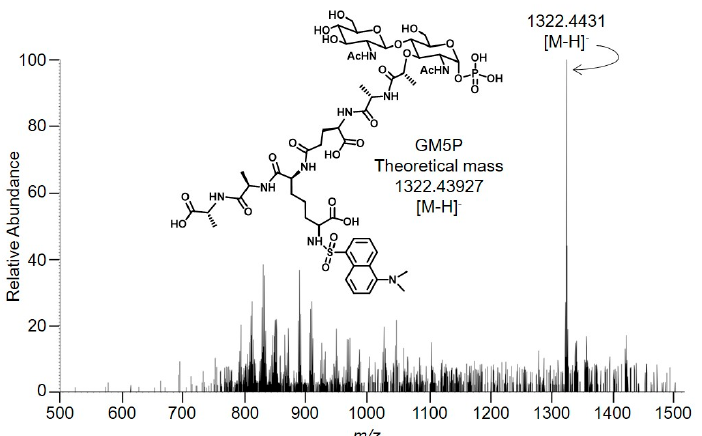
Figure 5. Characterization of Lipid II digestion products by mass spectrometry. Five reaction mixtures, each containing 500 pmol LII(DAP)35 and 27.2 µ g rat liver microsomal protein, were incubated for 16 h as described in Section 4. After SPE with Vm-beads, the 15 mM NH 4 OH / H 2 O eluates were dried under vacuum and taken up in 25 µ L of H 2 O. This material was directly infused, via a nano-electrospray ion source, into an Orbitrap Fusion mass spectrometer. The spectrum obtained in negative ion mode and